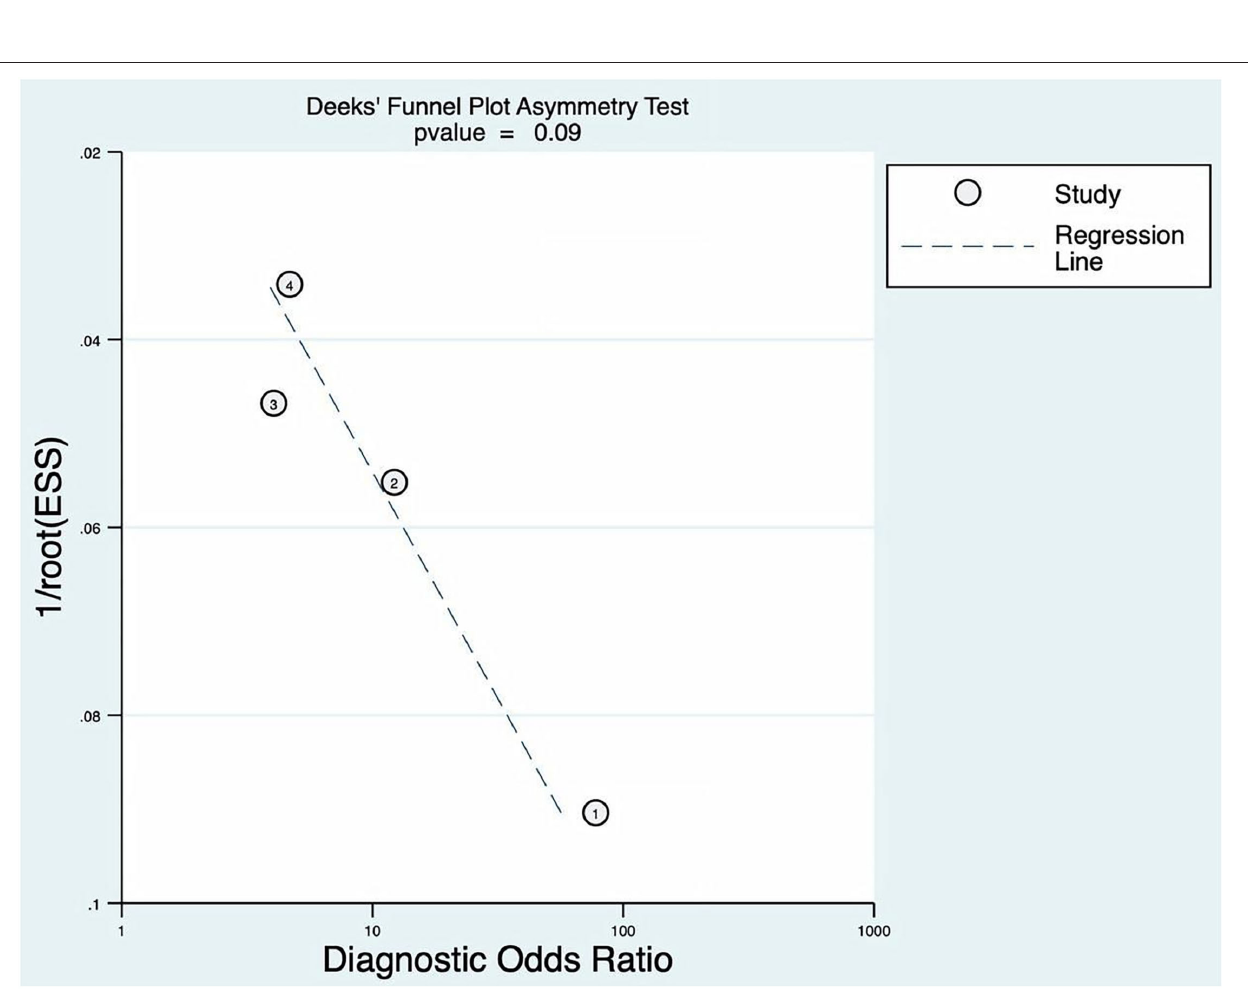
ratio (DOR), and to draw the symmetric receiver operator characteristic curve (SROC) so as to estimate the total diagnostic accuracy. Pre-test probabilities may be estimated from routine